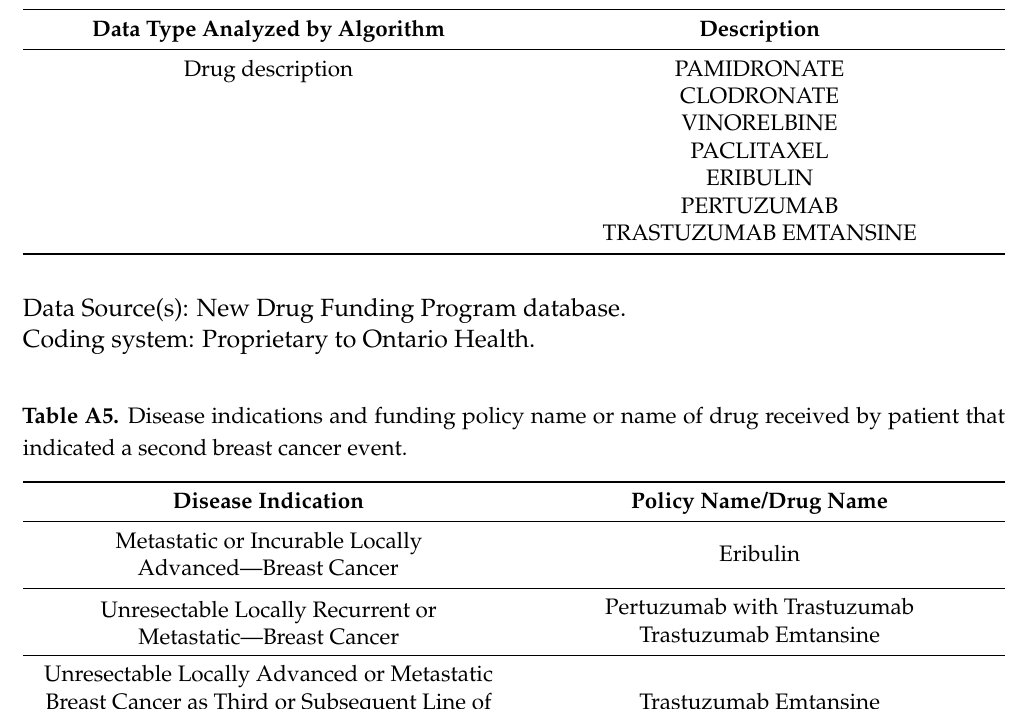
Table A4. Systemic therapy data types and descriptions that indicated a second breast cancer event.